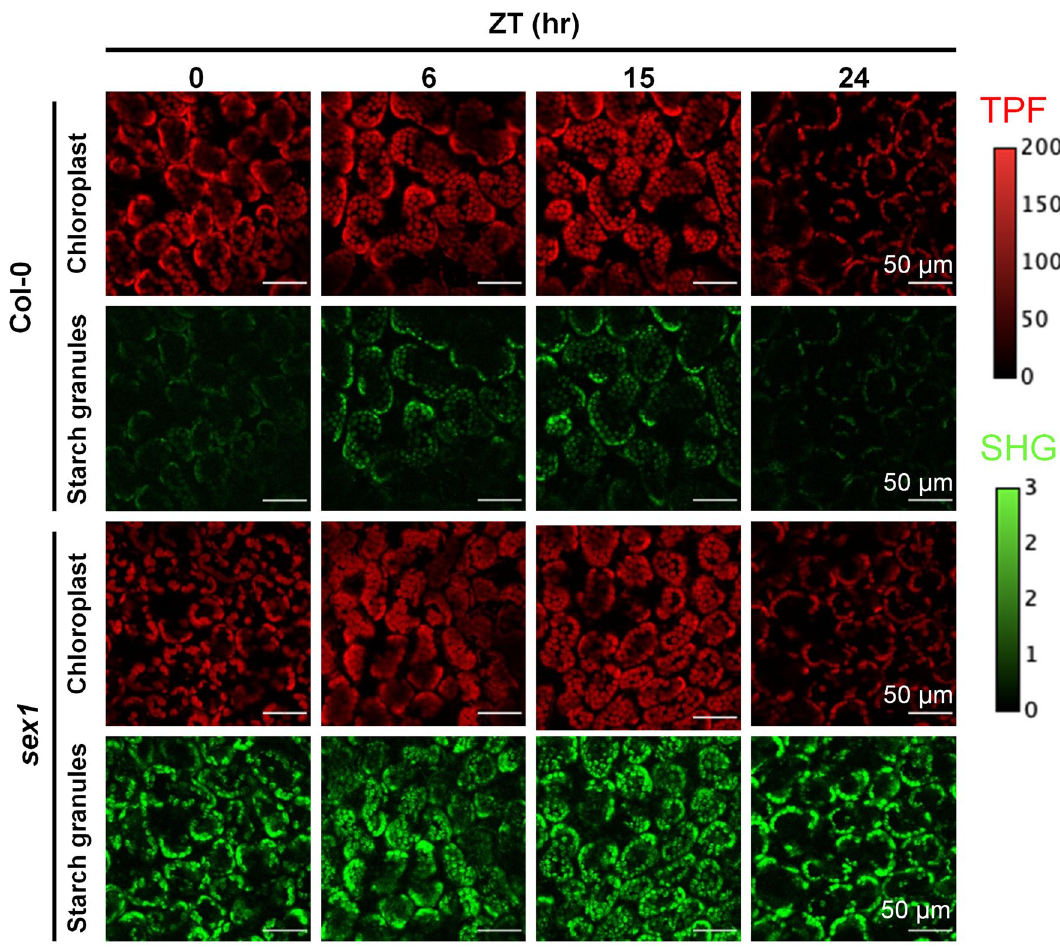
Figure 4. Diurnal variations of starch granule in Arabidopsis with TPF-SHG imaging. TPF (red) and SHG (green) imaging of fresh intact Col-0 and sex1 leafs at different Zeitgeber Time (ZT) hours. For Col-0, variations in the SHG intensity can be seen for the different ZT